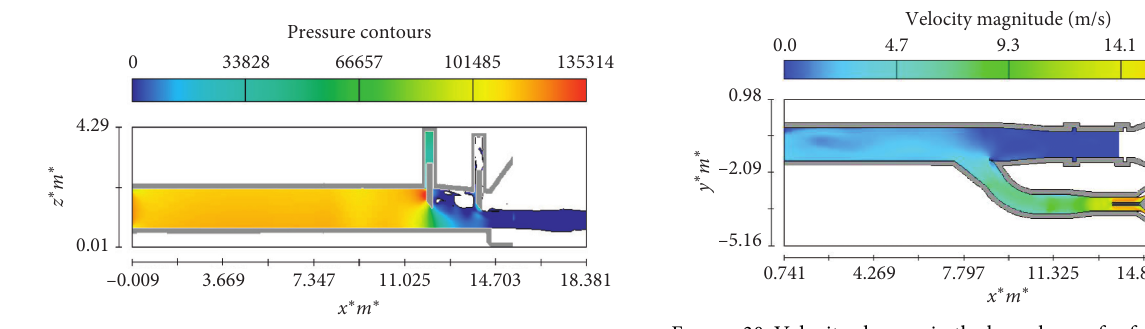
Figure 27: Pressure changes in the bottom outlet’s tunnel of Sardab Dam at the time of 50% opening of service and emergency gates.